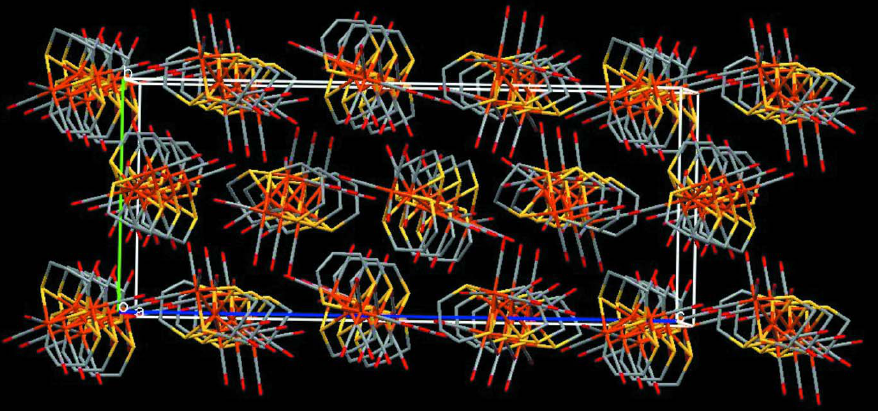
Figure 1 The molecular structure of (I) with displacement ellipsoids drawn at the 30% probability level. Only one of the two independent molecules is displayed, and H atoms have been omitted for clarity.